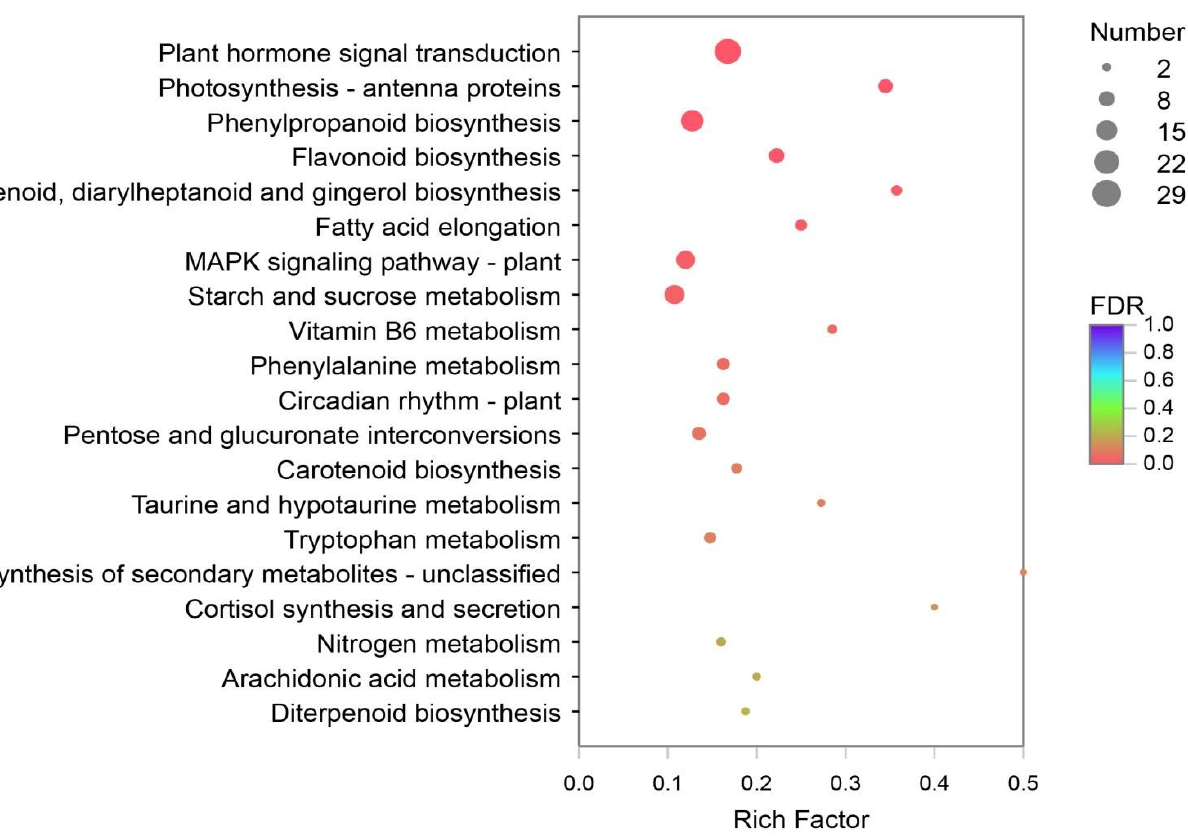
Figure 6. The Kyoto Encyclopedia of Genes and Genomes (KEGG) enrichment analysis with the DEGs. A total of 463 DEGs were assigned to 111 KEGG pathways, and the plant hormone signal transduction pathways were most frequently represented.